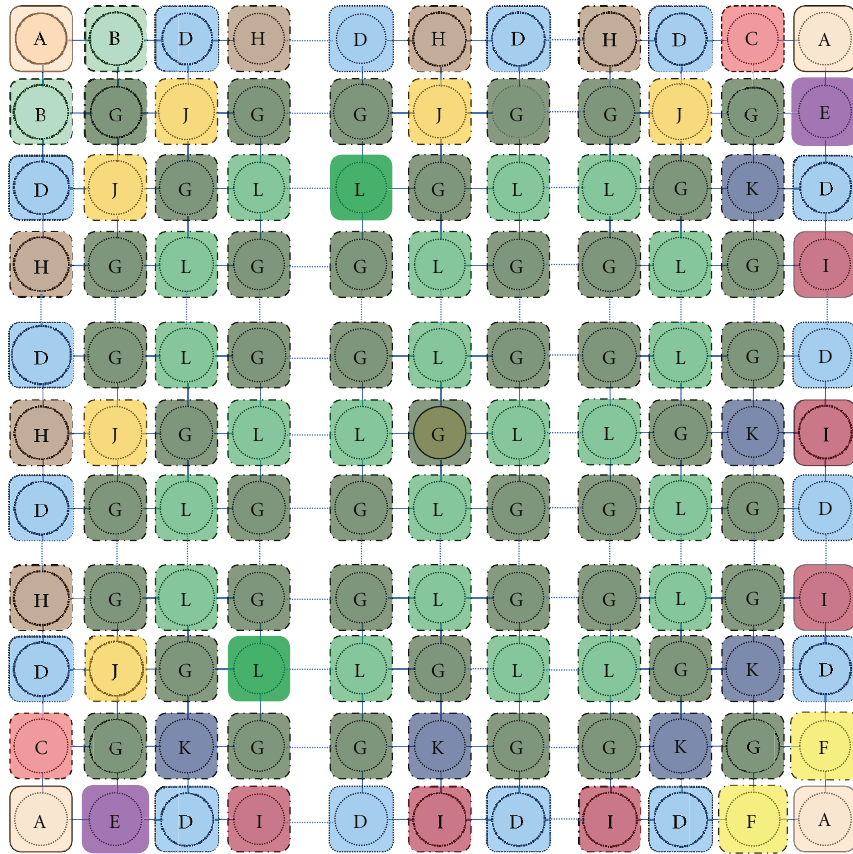
Figure 8: Di ff erent cases used for signaling cost analysis of HH-MIP.